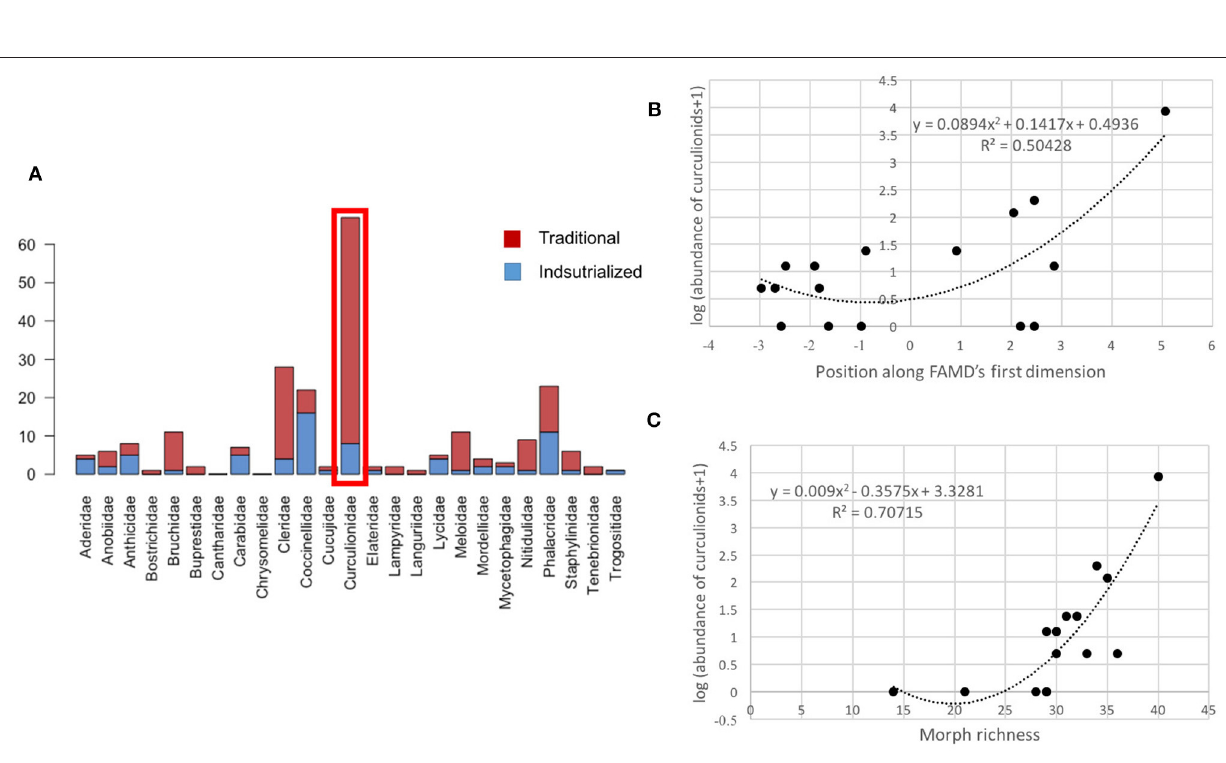
Frontiers in Sustainable Food Systems |